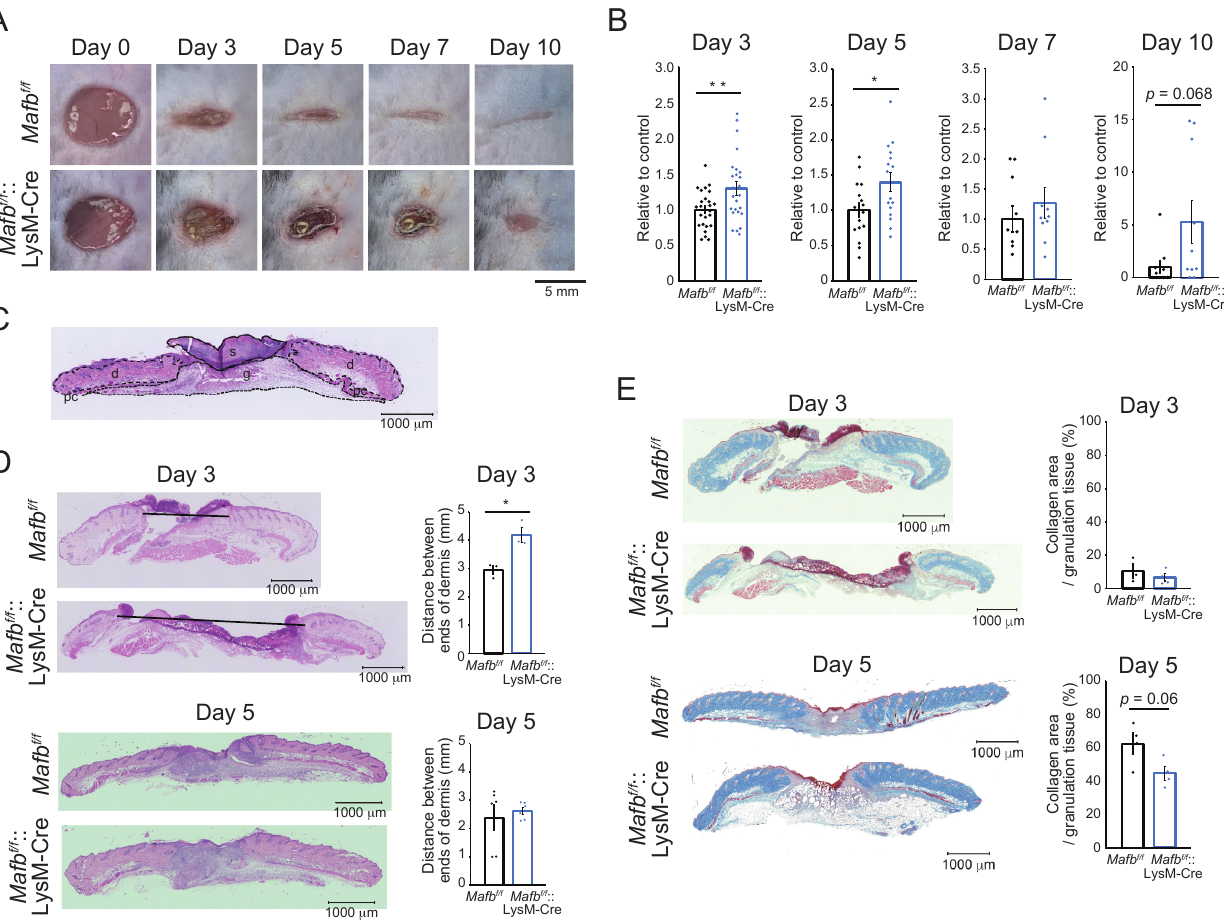
Figure 1. Wound healing impairment in Mafb f/f ::LysM-Cre mice. ( A ) Representative photographs of the wounds in Mafb f/f and Mafb f/f ::LysM-Cre mice on days 0, 3, 5, 7, and 10 post-injury. ( B ) The wound areas were analyzed using Photoshop on days 0, 3, 5, 7, and 10. The wound area at day 0 was set as 100%. The wound areas in the Mafb f/f mice were normalized to the mean % of wounds in Mafb f/f mice (control). The wound areas in the Mafb f/f ::LysM-Cre mice were also normalized to the mean % of their wound areas and analyzed. ( C ) Hematoxylin and eosin (H&E) staining of various wound tissues (s: scab, d: dermis, g: granulation tissue, pc: panniculus carnosus). ( D ) Tissues at the wound sites were harvested on days 3 and 5 and stained with H&E. Graph showing the area of the dermis. ( E ) Masson’s trichrome staining of the wound sections was performed on days 3 and 5. Graph showing the % collagen area per granulation tissue area. Data are means ± S.E.M; * p < 0.05, ** p < 0.01, Student’s t -test. Each dot represents data for a single